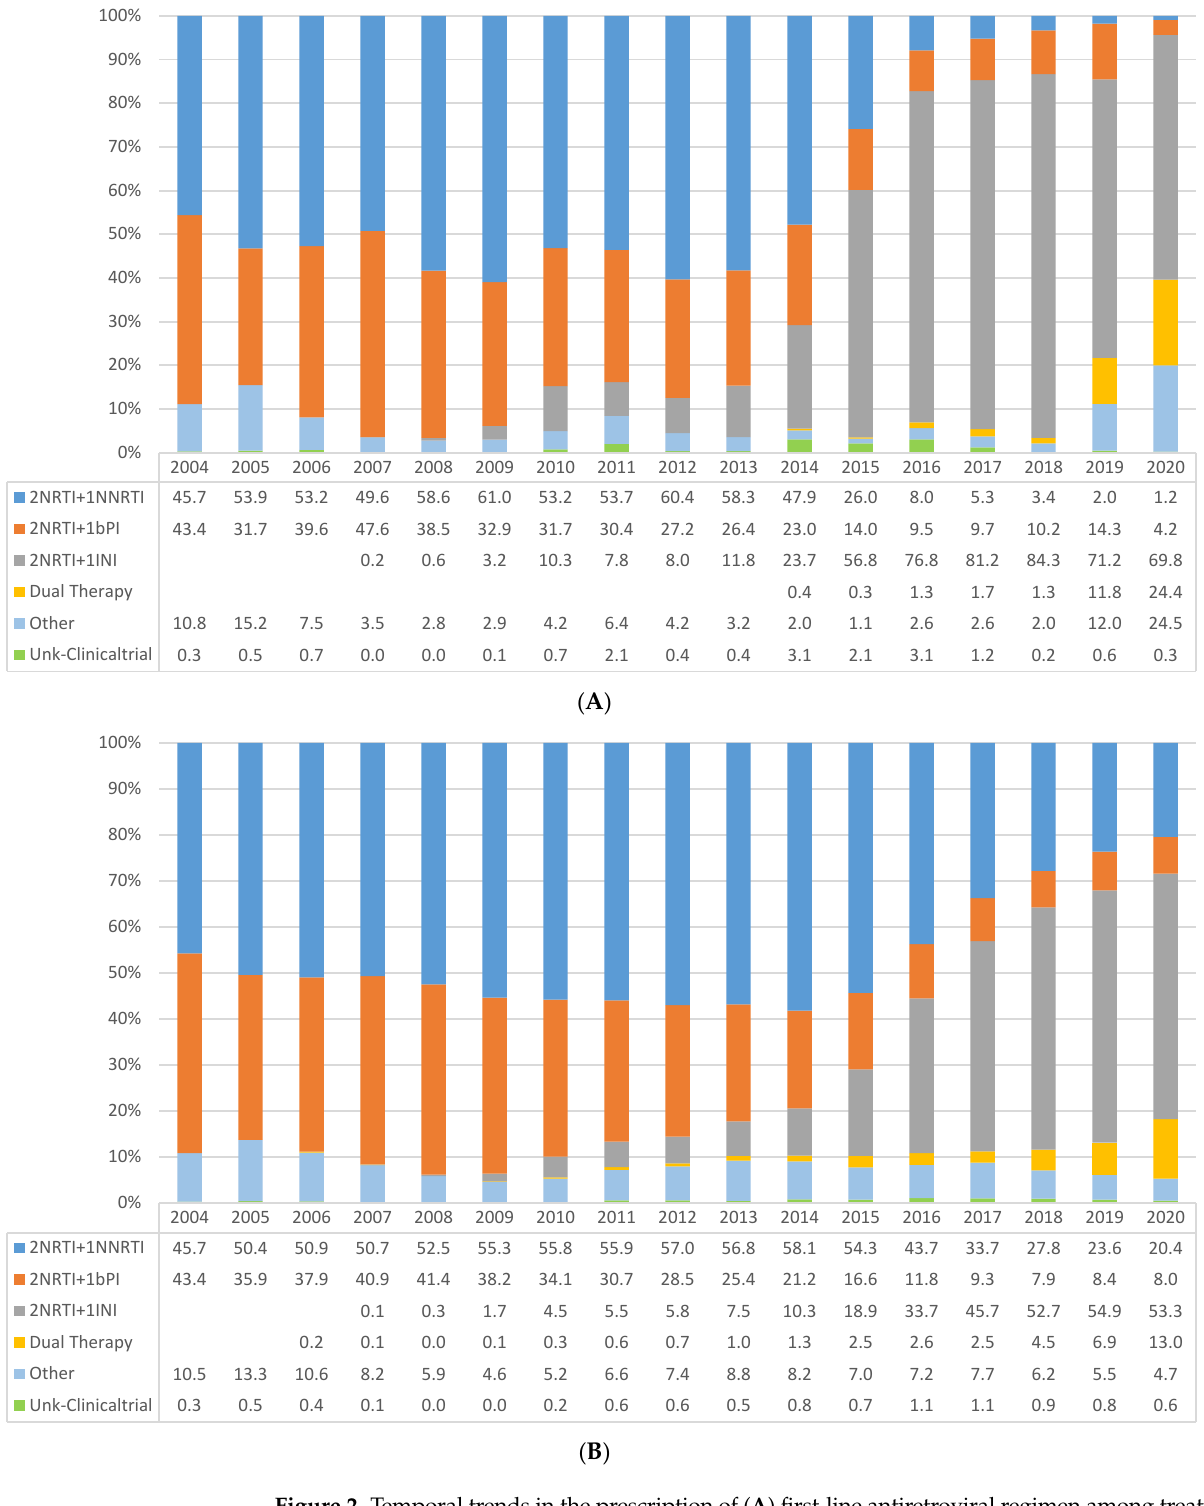
Figure 2. Temporal trends in the prescription of ( A ) first-line antiretroviral regimen among treatment-naïve patients and (Dual therapies as initial treatment were DTG/3TC and ETR + RAL). ( B ) ART regimen among all patients on treatment, by type of regimen, 2004–2020.(Dual therapies among patients on treatment were DTG/RPV, DTG/3TC, DRV/r + 3TC, DRV/r + RPV, DRV/r + ETV, DRV/r + DTG, DRV/r + RAL, CAB + RPV, ATV/r + 3TC, ETR + RAL, and DRVc +